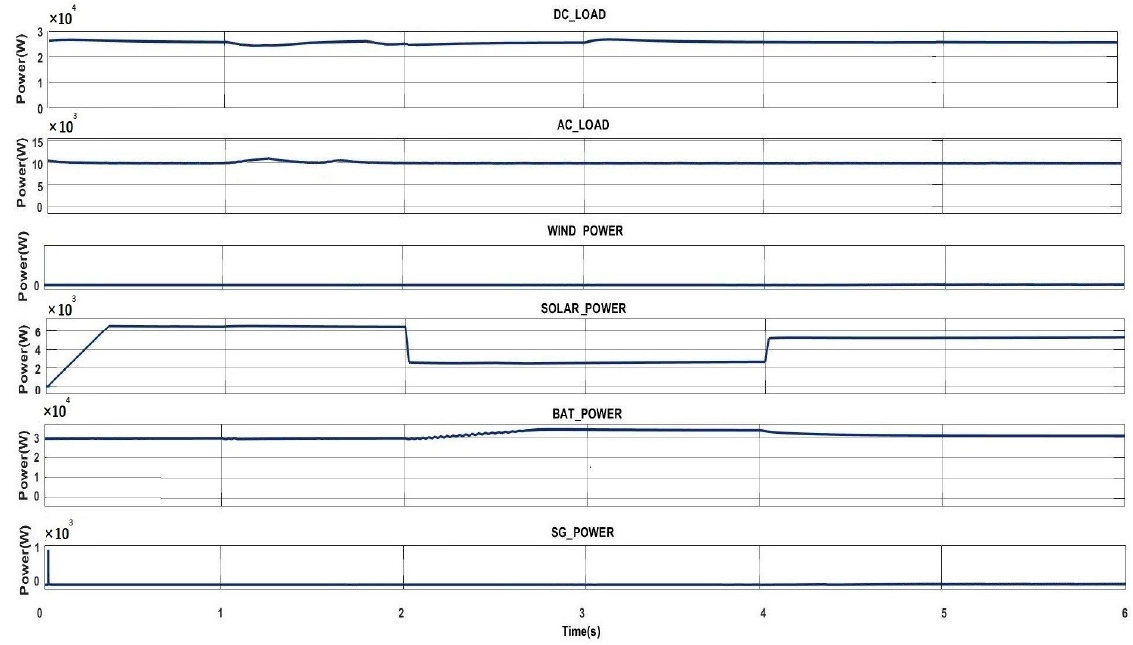
Figure 10. The variation in the power level of each unit in the microgrid for different operation conditions with no wind speed.